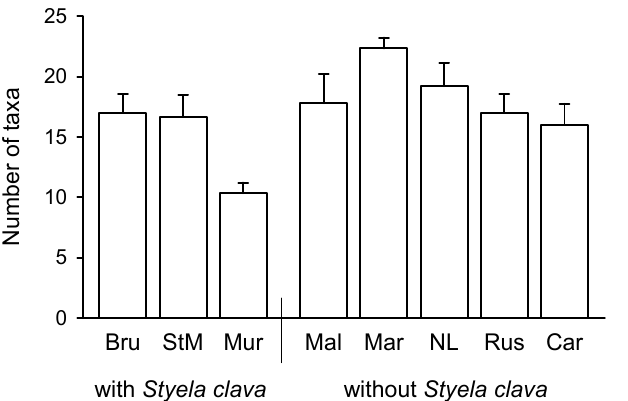
Figure 5. Taxonomic richness (±SE) of mussel sock macroinvertebrate samples from mussel leases in bays with and without Styela clava .